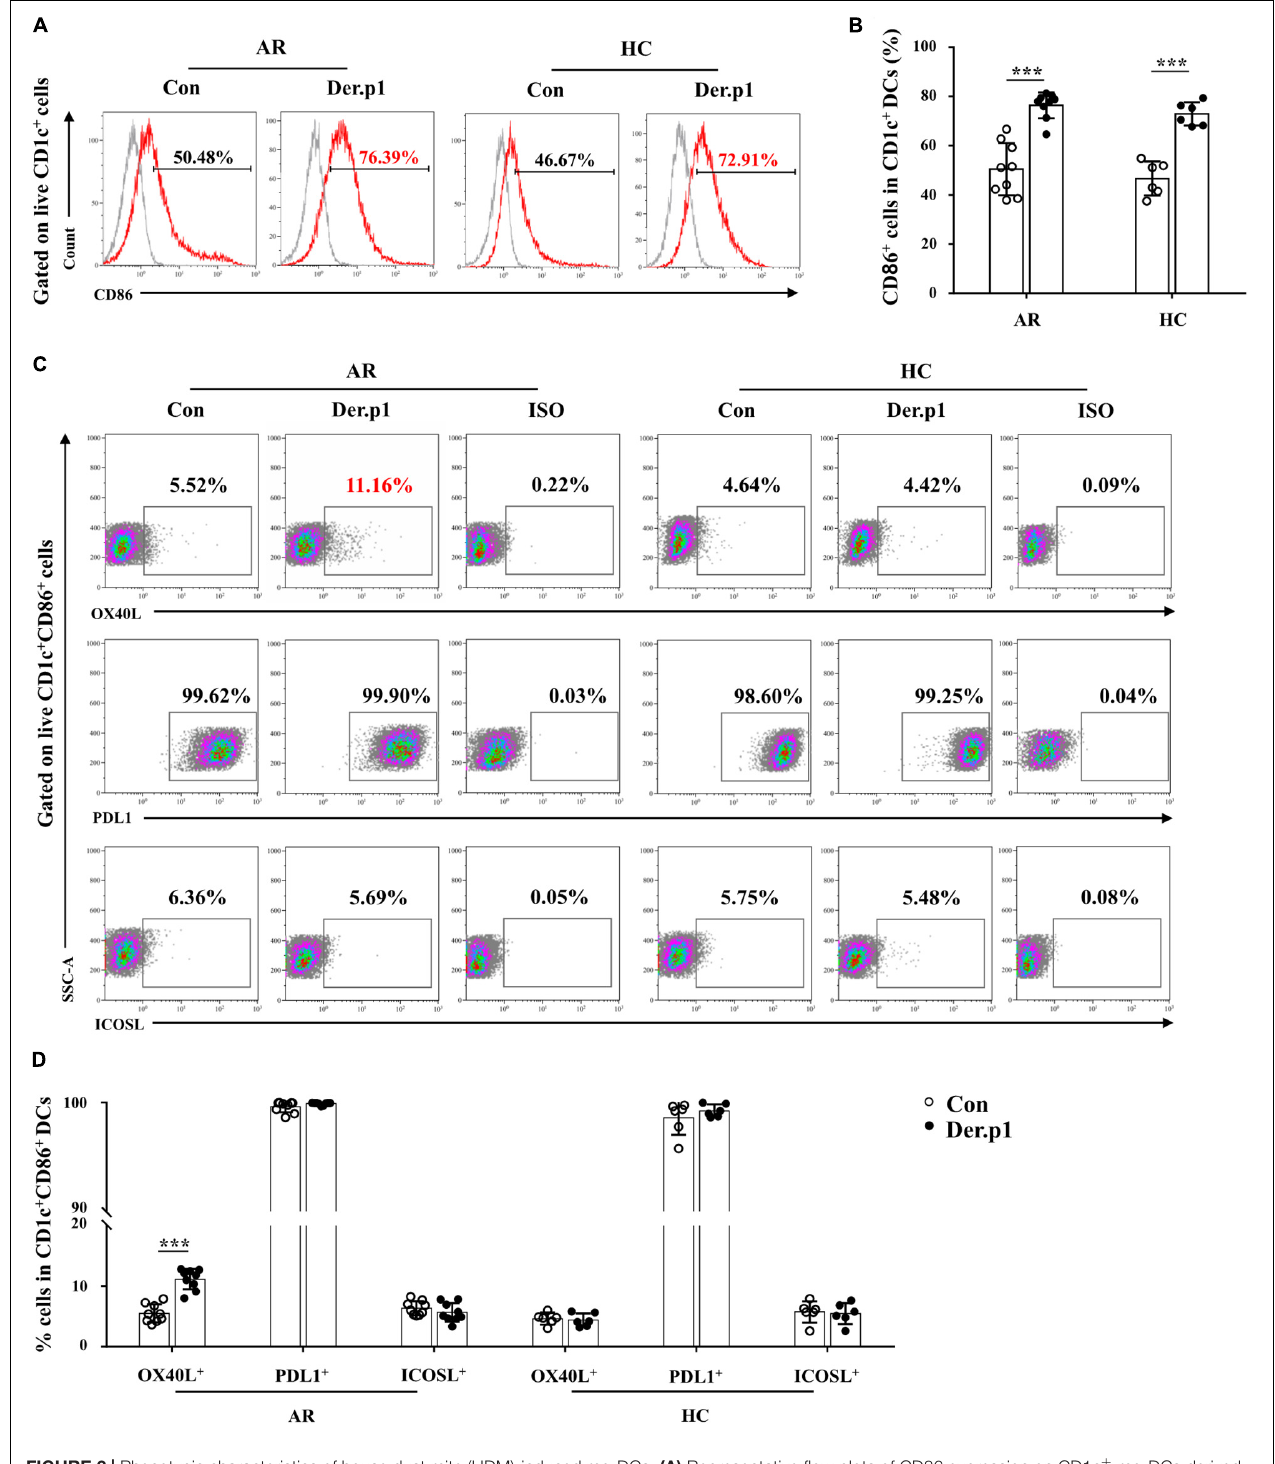
FIGURE 2 | Phenotypic characteristics of house dust mite (HDM)-induced mo-DCs. (A) Representative flow plots of CD86 expression on CD1c + mo-DCs derived from AR ( n = 9) and HC ( n = 6) subjects before and 48 h after stimulation with Der.p1. Gray histograms were negative isotypes. (B) Quantification of percentages of CD86 + cells in CD1c + mo-DCs. (C) Representative flow plots of OX40L, PDL1, and ICOSL expression on CD1c + mo-DCs derived from AR ( n = 9) and HC ( n = 6) subjects before and 48 h after stimulation with Der.p1. (D) Quantification of percentages of OX40L + , PDL1 + , and ICOSL + cells in CD1c + mo-DCs. Data are expressed as means ± SD, and tested using the paired t -test. *** P < 0.001.